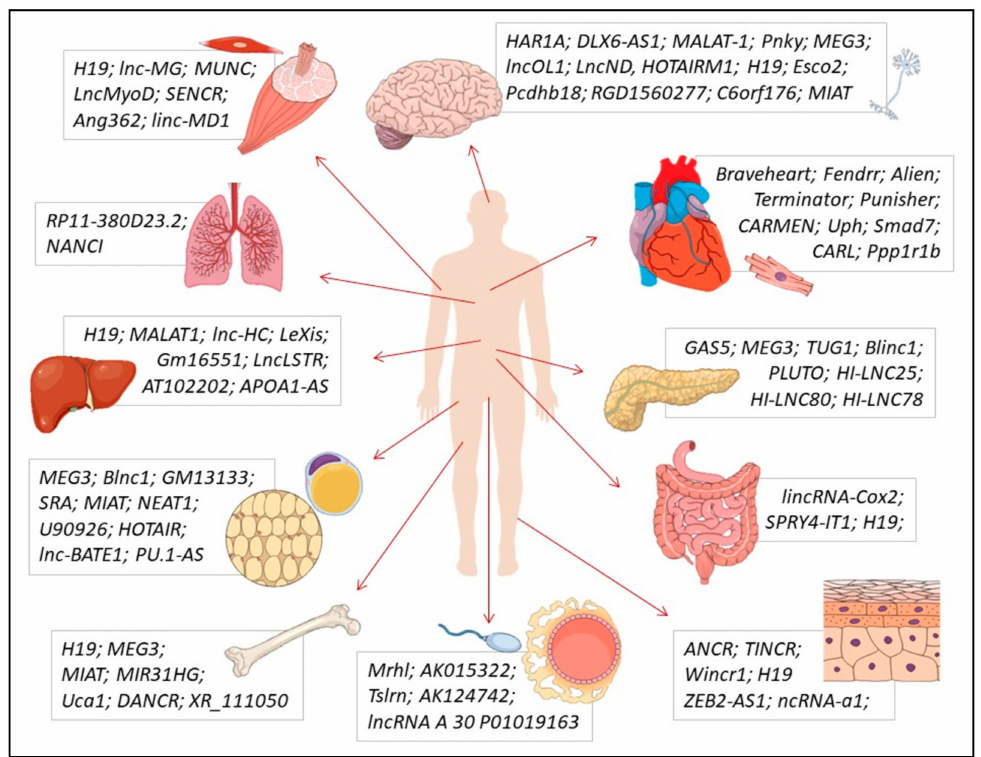
Figure 3. Main lncRNAs described as playing physiological roles (in function, homeostasis, and/or differentiation) in the following (clockwise direction): nervous, cardiac, pancreatic, intestinal, epidermal, germ, bone, adipose, hepatic, lung, and muscular (skeletal and smooth)